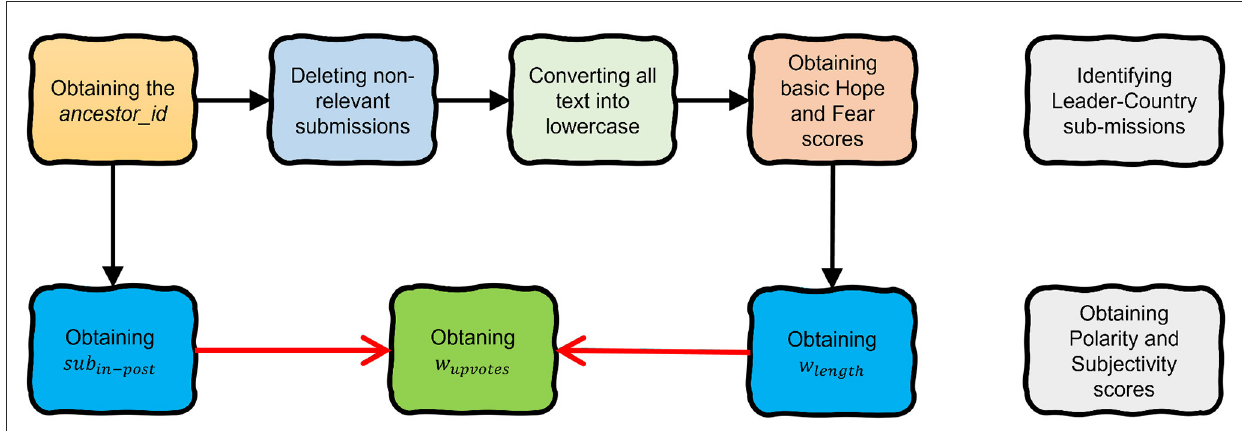
FIGURE1 The pre-processing workflow shows the stages of obtaining the emotion of w upvotes . The two gray blocks on the right show additional pre-processing stages required for the experimental analyzes in this article.